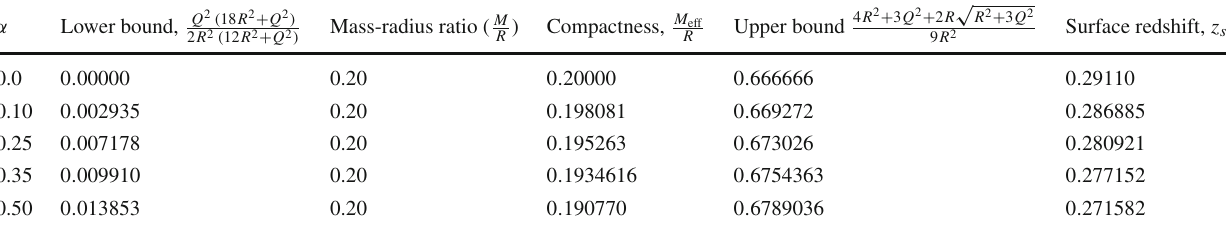
Table 2 Comparative study of lower bound, mass-radius ratio, upper bound, compactness ( u = M eff / R ) and surface red-shift of the star for different values of α